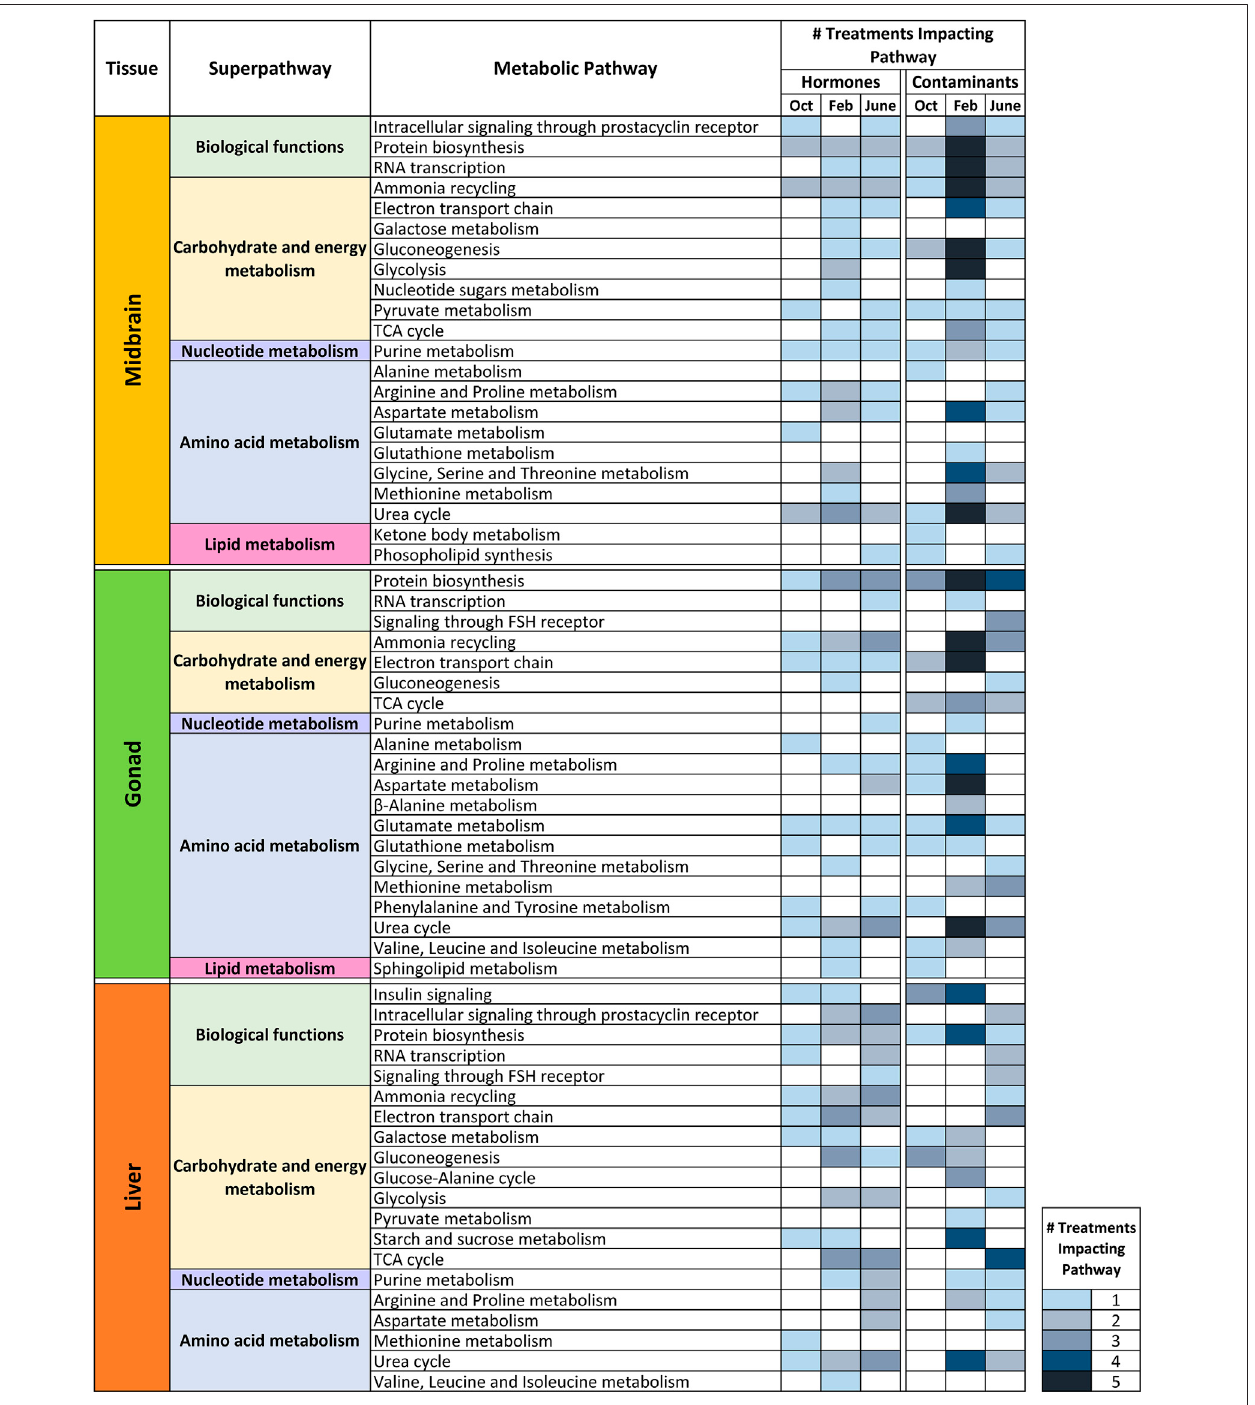
Frontiers in Toxicology |